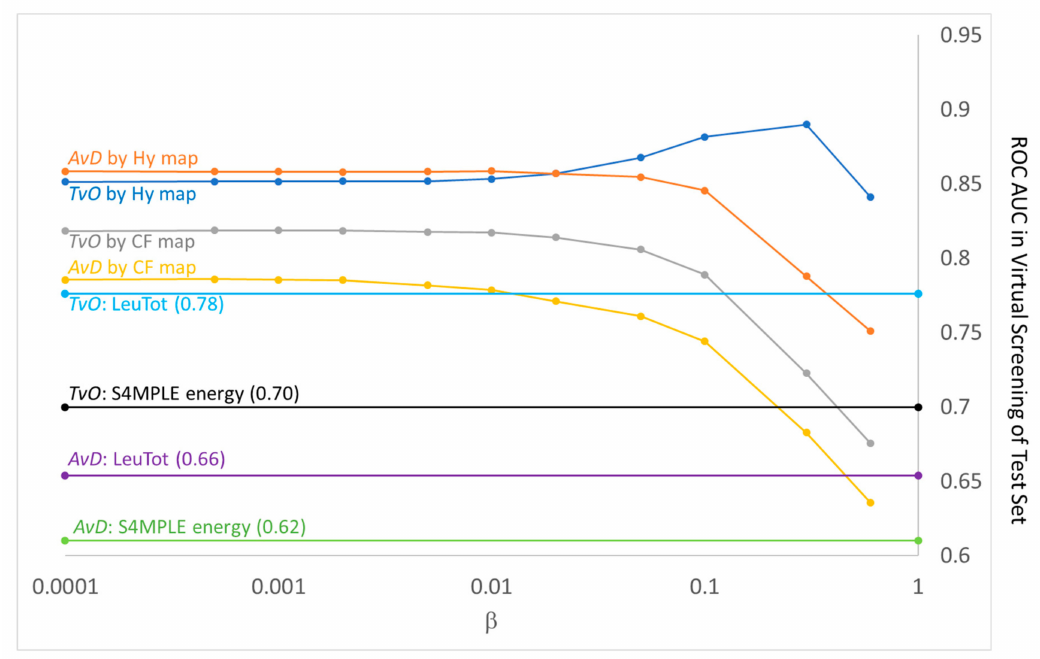
Figure 11. Comparison of ROC AUC levels in challenges to prioritize the “actives” in virtual screening scenarios TvO (Top-versus-Others) and AvD (Actives versus Decoys), as introduced in Section 3.7. All data refer to the 146 test compounds not serving to build the β -dependent activity landscapes on the CF and HY maps. The thereby generated β -dependent pK pred values served to build β -dependent ROC curves labeled “scenario by map” above. By contrast, standard ligand ranking criteria such as S4MPLE energy and degree of satisfaction of simultaneous contacts at both key atoms = O and > NH of Leu 83 produce one single ROC curve per scenario, the AUC of which is rendered by corresponding horizontal